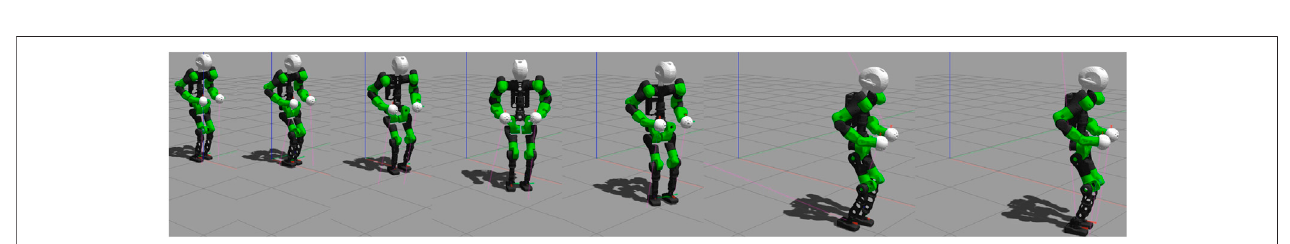
FIGURE13| Theoutput ofthePCistheCoM trajectory (inyellow) commanded totherobot.SequenceofframesofCOMAN+walking 32stepsinsimulationwhile changing the heading direction.Sequence of frames of COMAN + walking 10 step and steering of 10 ° at step 3 according to the issued command.